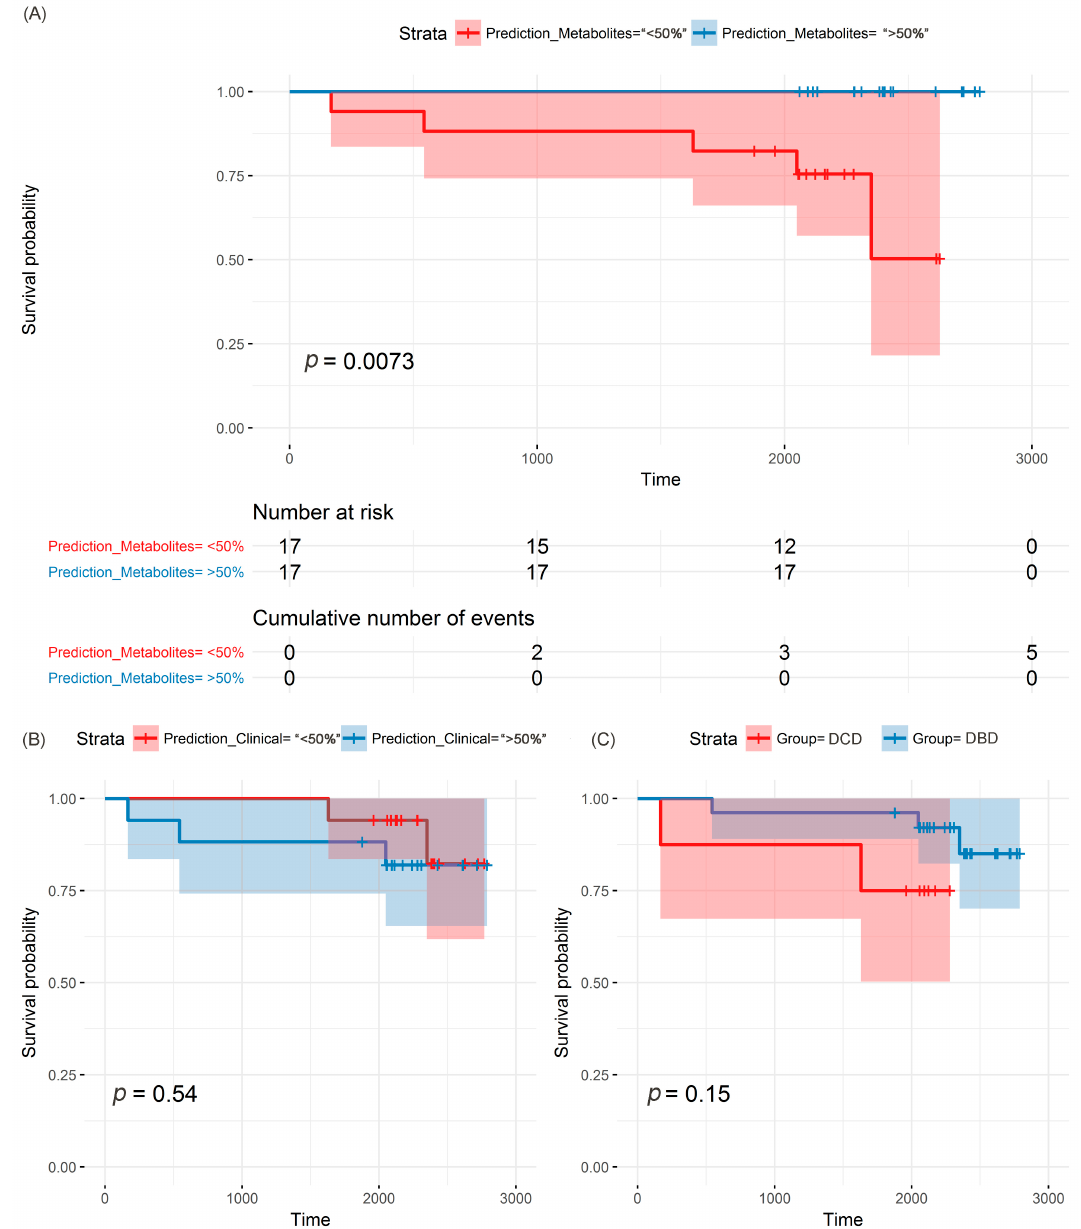
Figure 3. Kaplan–Meier plots of patients’ survival estimates, using three different types of predictors: ( A ) metabolite ratios, ( B ) clinical variables, ( C ) donation group.